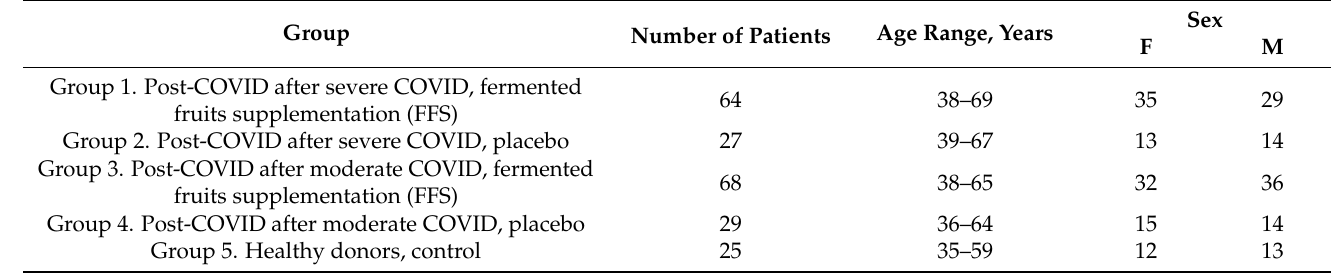
Table 1. Demographic distribution of post-COVID patients and donors in the treatment groups.